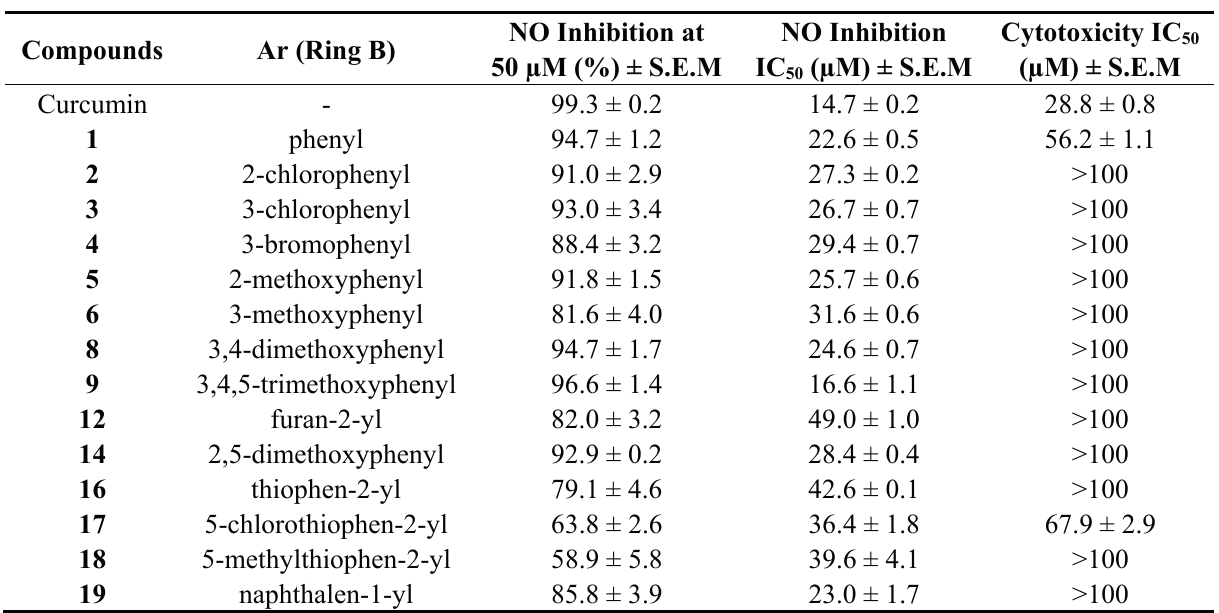
Table 1. Nitric oxide (NO) suppression activity and cytotoxicity of active compounds in diarylpentenedione series on RAW 264.7